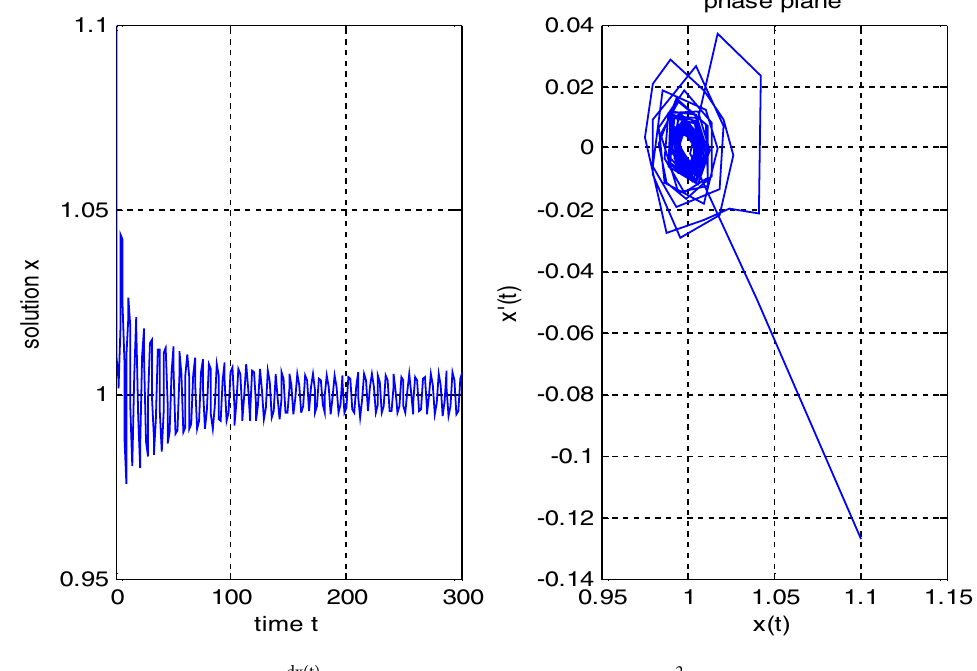
Figure 5. Limit cyclic for Eq. dx(t) dt